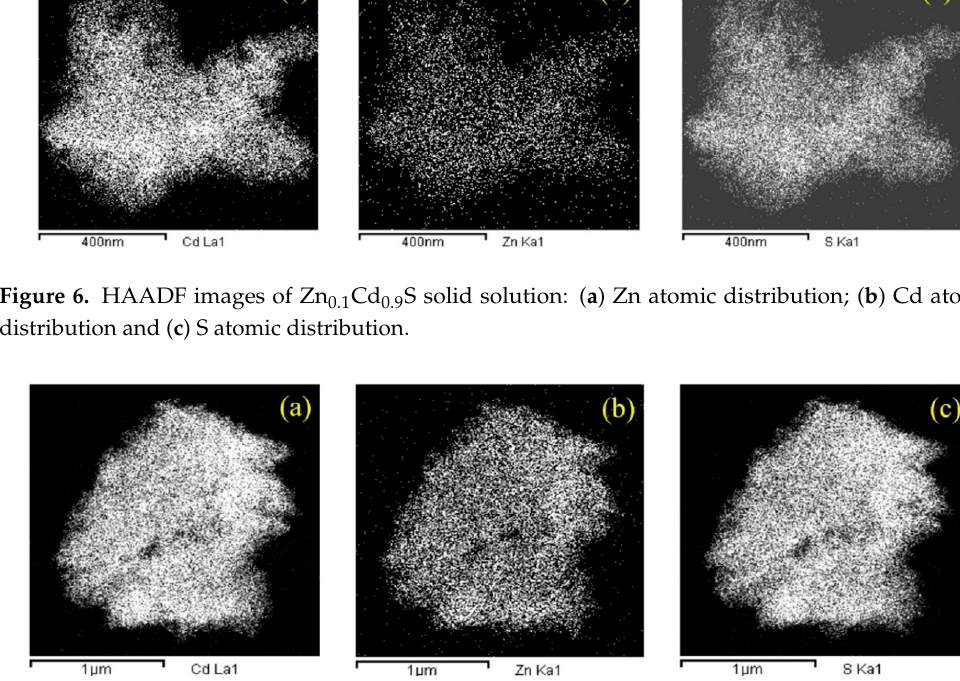
Figure 7. High-angle annular dark field (HAADF) images of Zn 0.2 Cd 0.8 S solid solution: ( a ) Zn atomic distribution; ( b ) Cd atomic distribution and ( c ) S atomic distribution.